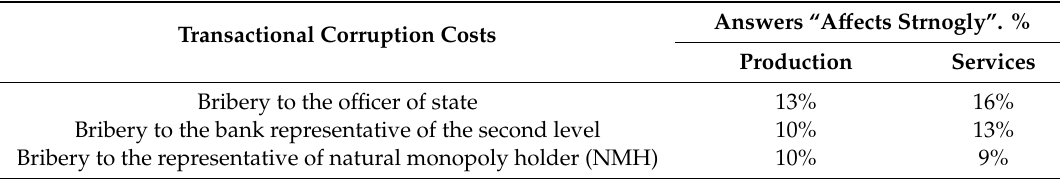
Table 7. Corruption